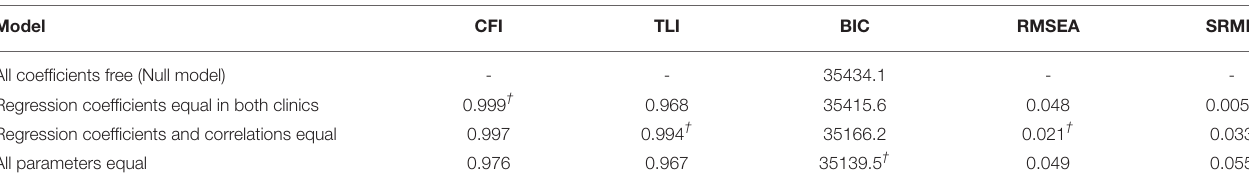
TABLE 3 | Model fit indices for path models across two clinics.